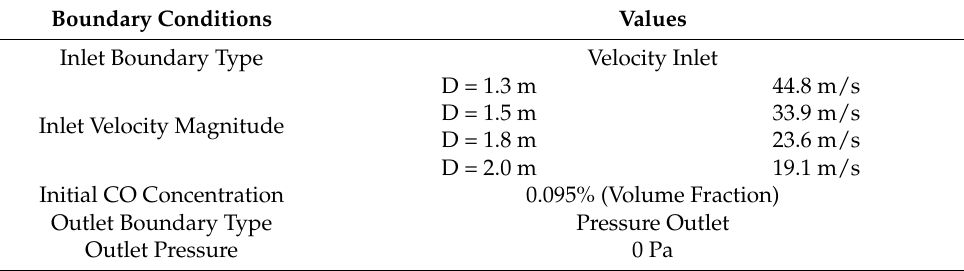
Table 3. Boundary conditions for Test 1.